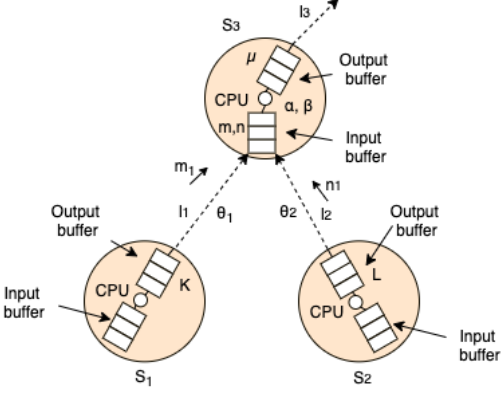
Figure 12. Architecture of the sensor